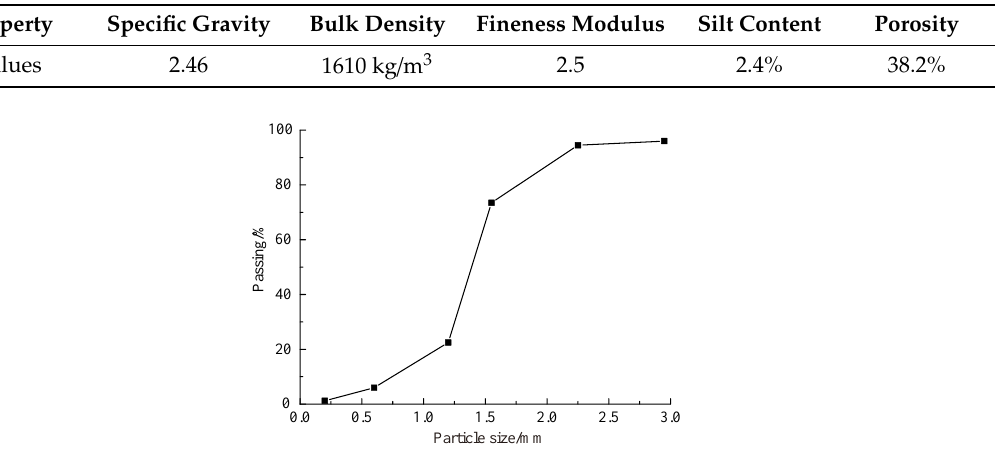
Table 3. Physical properties of the river sand.